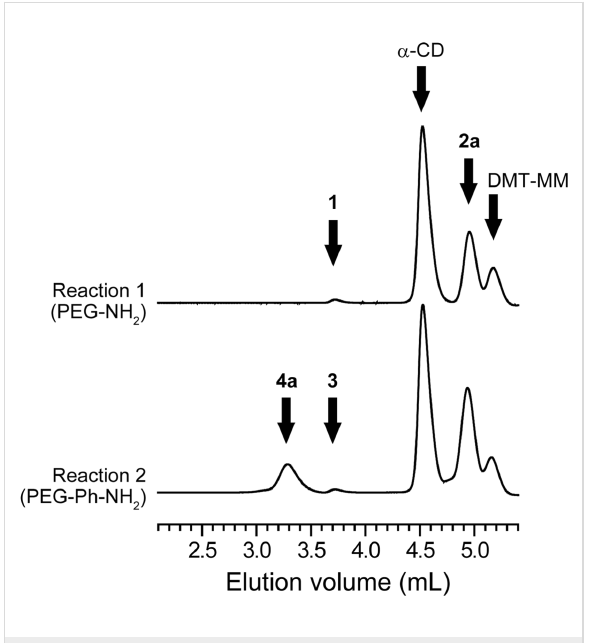
Figure 1: SEC charts for crude products of reaction 1 (upper chart) and 2 (lower chart).